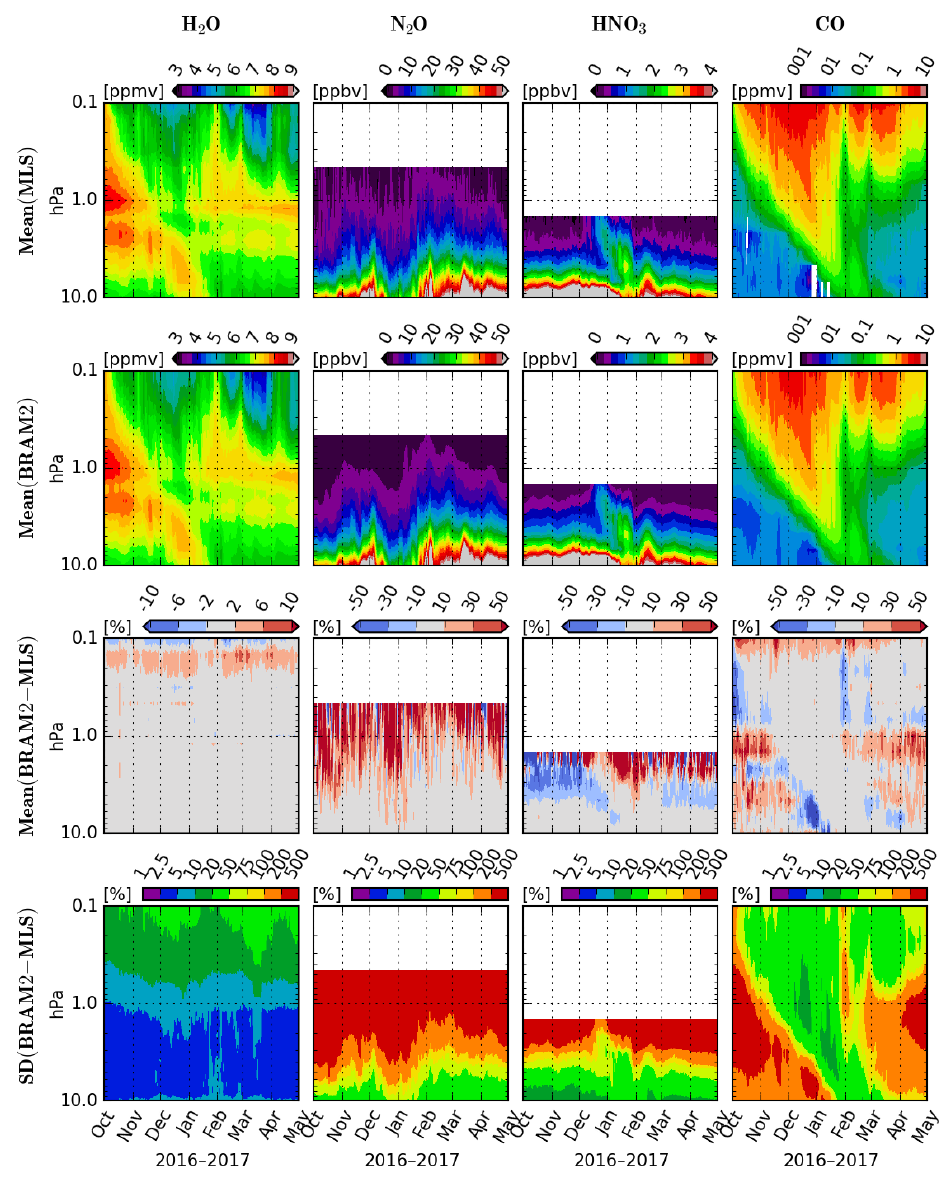
Figure 9. Time series of (from top to bottom) daily mean MLS profiles, the corresponding BRAM2 values, the relative mean differences (%) between BRAM2 and MLS, and the associated standard deviation (%). Values are shown between October 2016 and May 2017, between 90 and 60 ◦ N, and between 0.1 and 10hPa for (from left to right) H 2 O, N 2 O, HNO 3 and